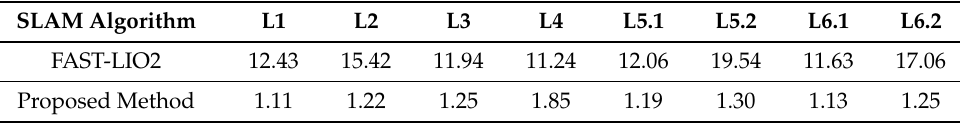
Figure 7. RTE results of the original and improved FAST-LIO2 in the flat terrain section of the tunnel environment: ( a – d ) single-loop runs, and ( e , f ) double-loop runs. Table 2. ATE (in meters) for one- and two-loop paths in the inclined section in the tunnel environment. L1–L4 represent the ATE for the one-loop paths, while L5.1–L6.2 represent that for the first and second loops of the two-loop